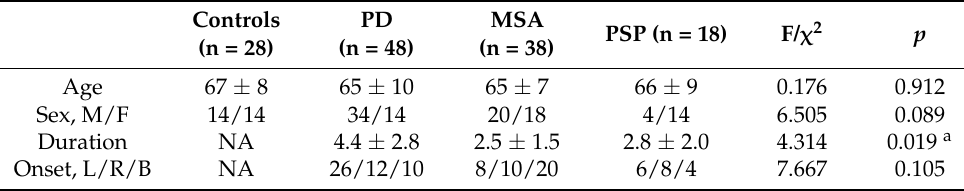
Table 1. Demographic features of PD, MSA, PSP, and